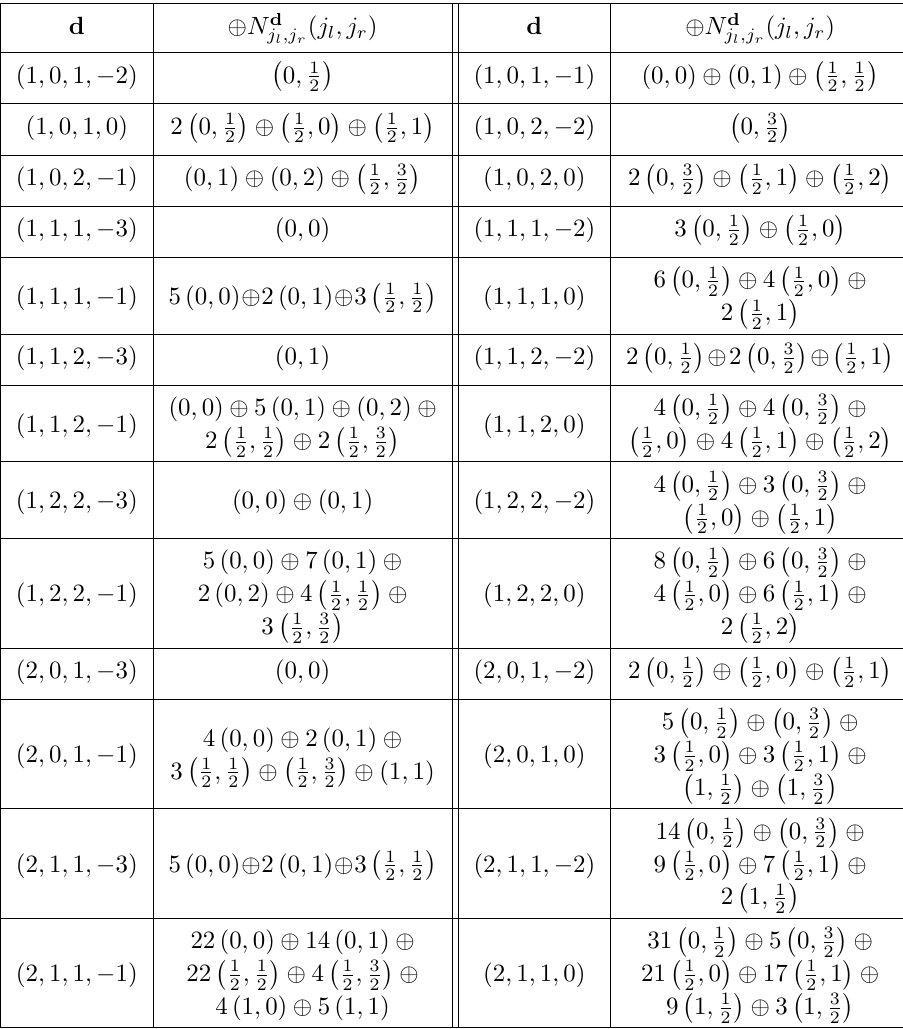
Table 20. BPS spectrum of SU(3) 0 + 1 Adj theory for d 1 = 1 , d 2 , d 3 ≤ 2 and d 1 = 2 , d 2 , d 3 ≤ 1 . Here d = ( d 1 , d 2 , d 3 , d 4 ) labels the BPS states with charge d 1 m 0 + d 2 α 1 + d 3 α 2 + d 4 m 1 , where α 1 and α 2 are simple roots of su (3) algebra. The states related by the symmetries d 2 ↔ d 3 and d 4 ↔ − d 4 are omitted.